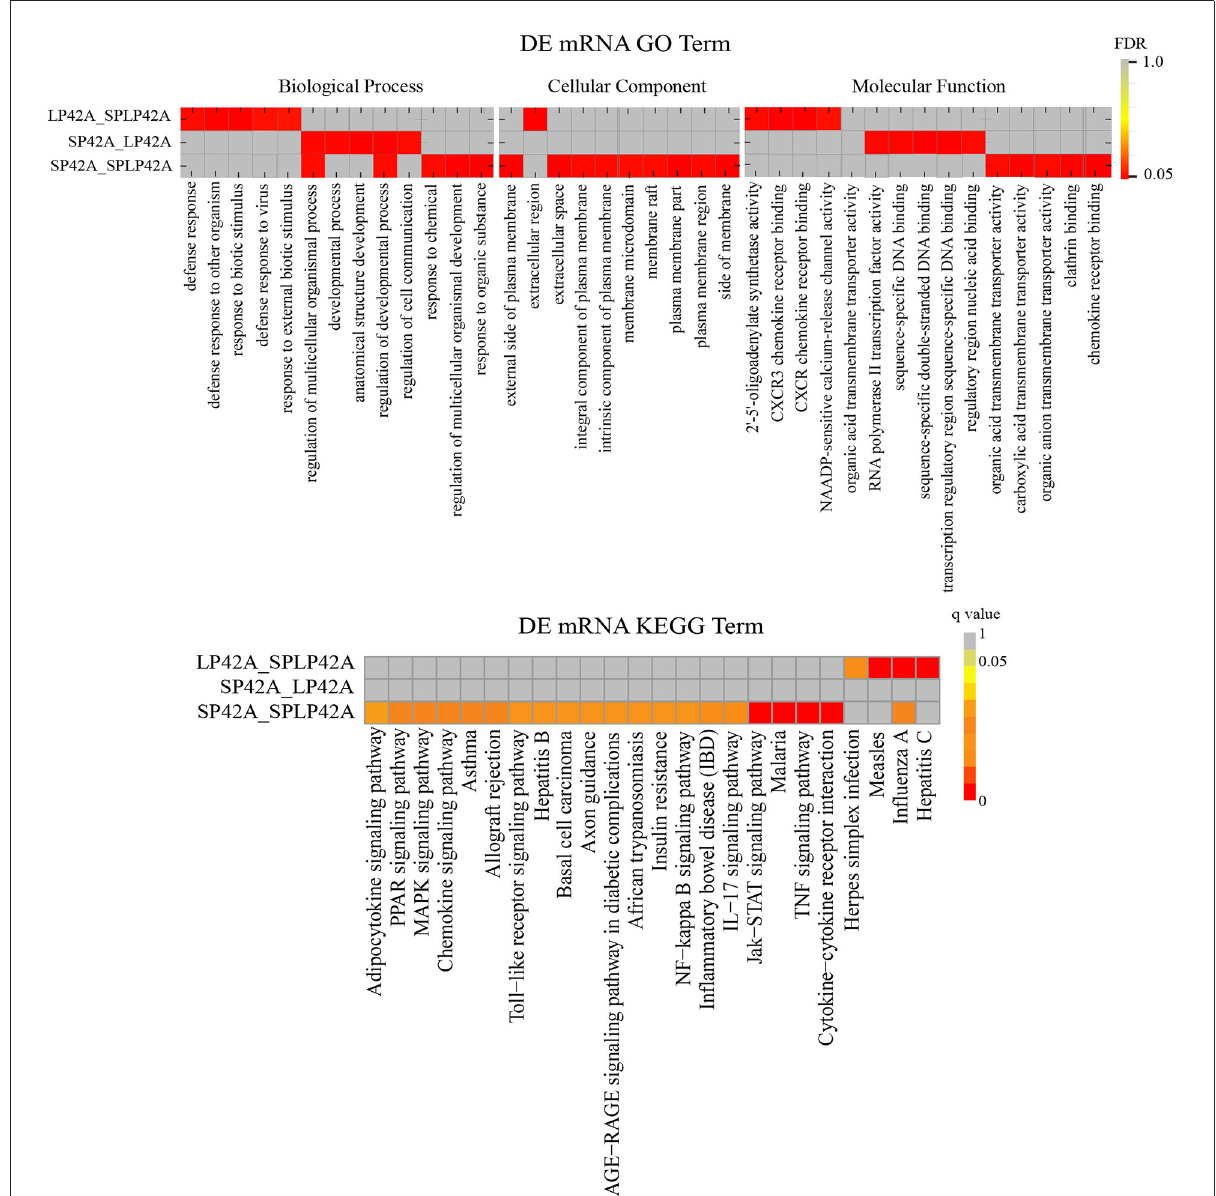
FIGURE5 Functional enrichment analysis of DEGs. The upper part of the picture shows the enrichment results of GO and the lower part shows the enrichment results of